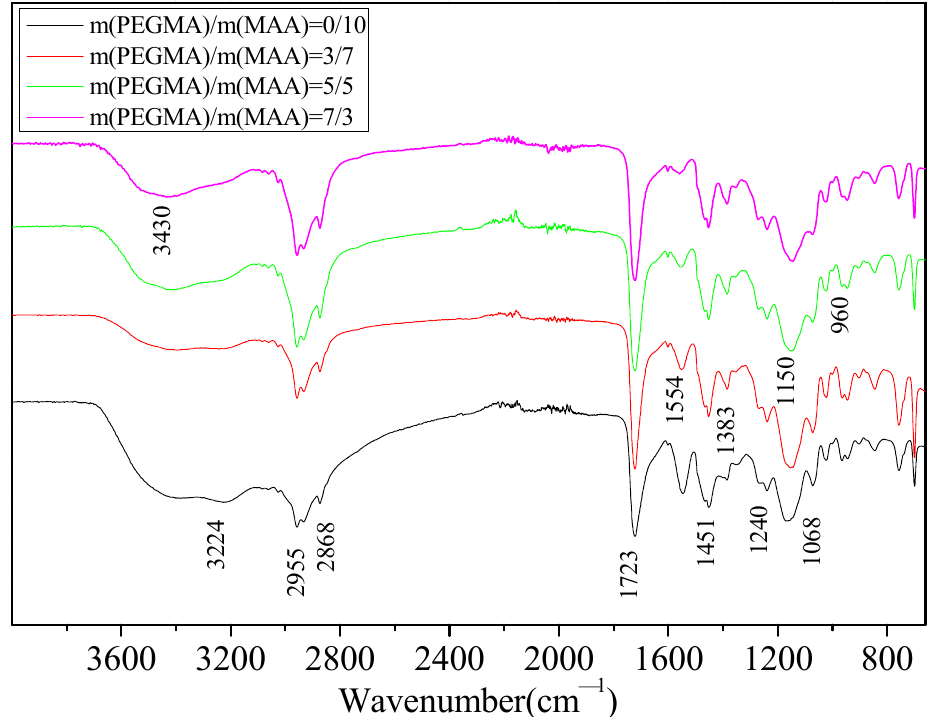
Figure 8. FTIR spectra of copolymer with different mass ratios of PEGMA/MAA. Polymerization conditions: m (MAA) + m (PEGMA) = 1.664 g; no MMA in the polymerization system; the MAA solution was neutralized by ammonia solution; m (BA)/ m (St) = 1/2; n (St)/ n (HEMA)/ n (BMA)/ n (BA)/ n (ACPA)/ n (I 2 ) = 18.36/18.74/40.36/7.46/1.15/1; the total mass of ingredients without ACPA solution and I 2 was maintained at 30.08 g in